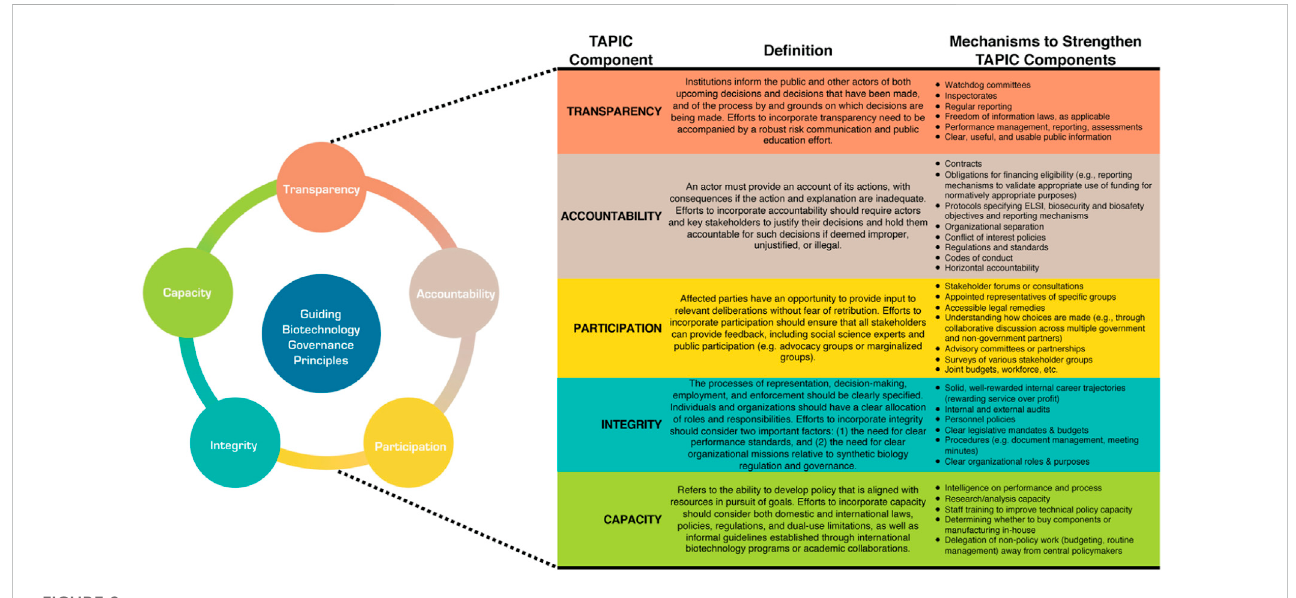
FIGURE 2 TAPIC framework for guiding biotechnology governance